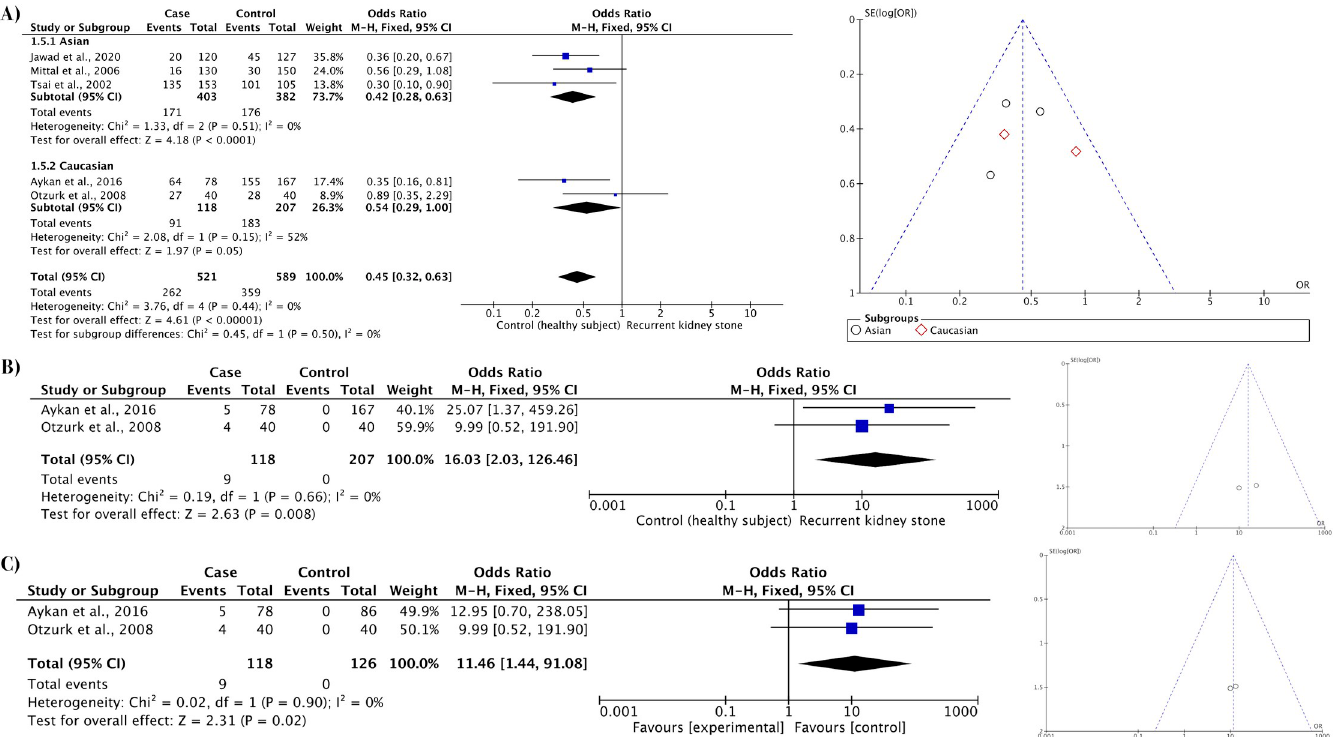
Fig 2. Forest and funnel plots for the ApaLI polymorphism. A) ApaLI polymorphism (recessive model) with healthy subject groups as controls. B) Sub–analysis of the ApaLI polymorphism (heterozygous model) among Caucasians with healthy subject groups as controls. C) Sub–analysis of the ApaLI polymorphism (heterozygous model) among Caucasians with first–time stone formers as